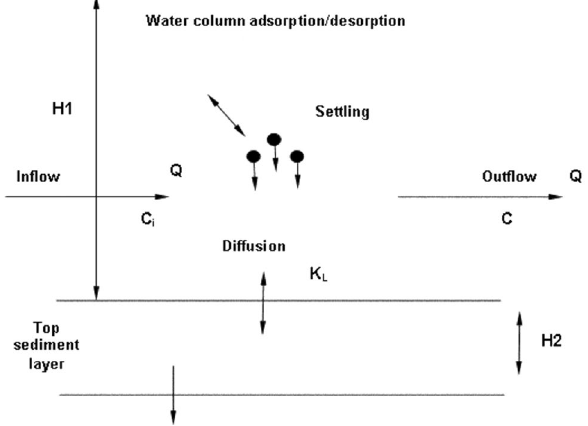
Figure 3. Heavy metals are transported and dispersed throughout the river system 34